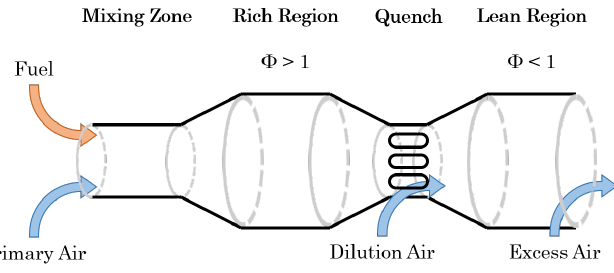
Figure 6. A diagram of a rich-quench-lean (RQL) burner. Fuel and primary air mix prior to entering the rich region. NOx is not formed in the rich region due to chemical phenomena. The exhaust gases from the rich region are quenched to yield a lean mixture for the final stage of the combustor. The quenching air lowers the temperature of the combustion gases to limit the formation of thermal NOx. The flow of combustion gases through the burner is continuous.